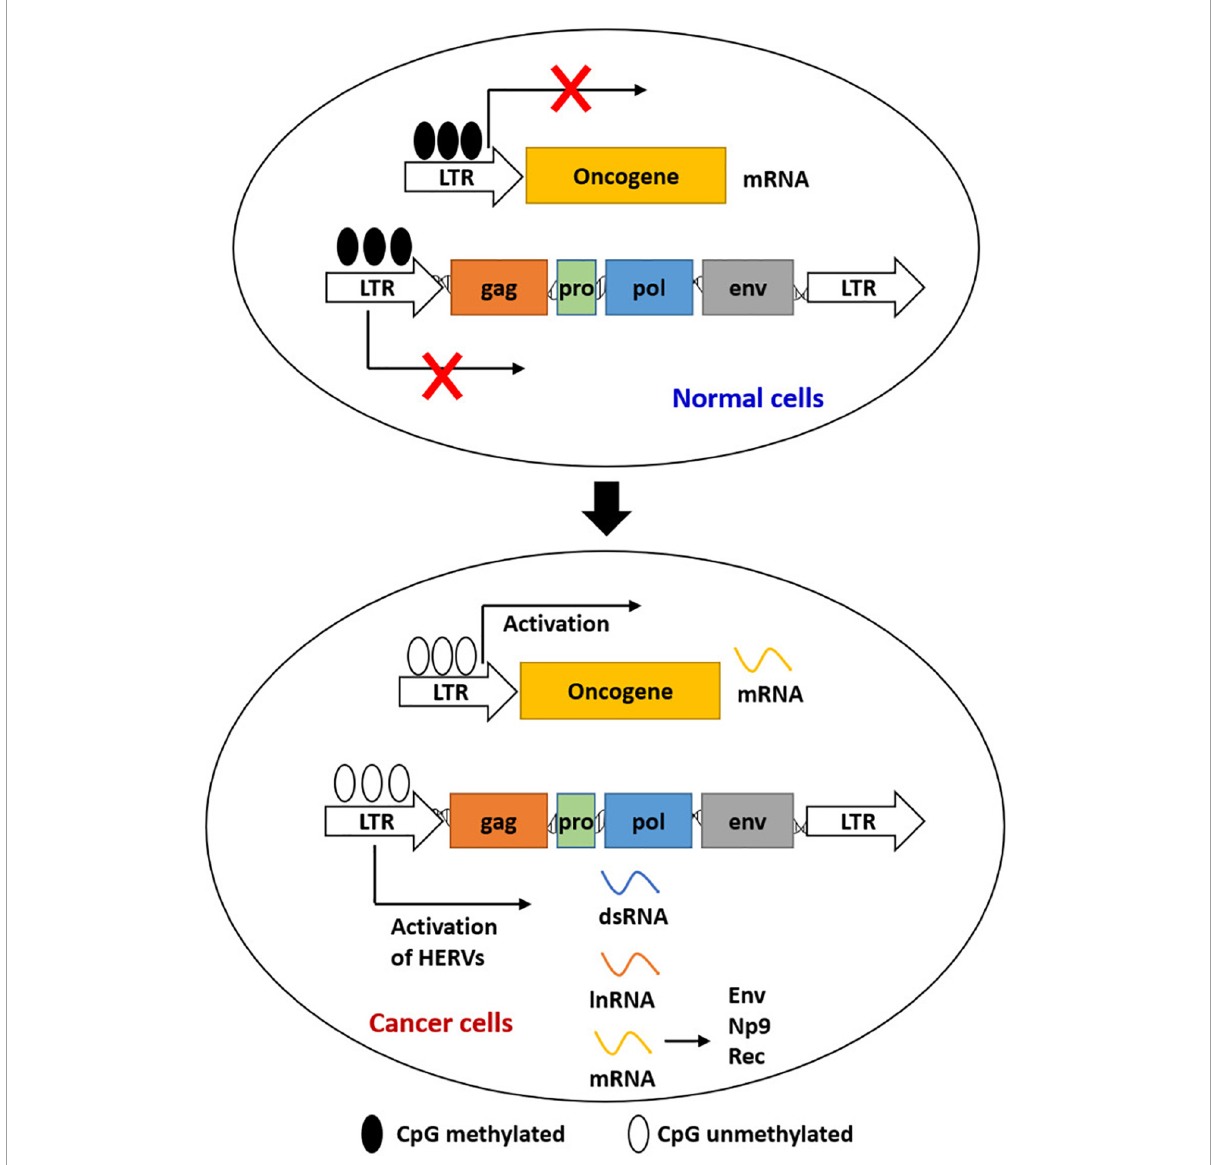
FIGURE1 Epigenetic regulation of the expression of HERVs and LTR-driven genes during carcinogenesis. Most HERVs/LTRs are inactivated in normal cells by DNA methylation. Activation of HERVs is induced by the global loss of DNA methylation in cancer cells. Activated HERVs can be transcribed into mRNAs, lncRNAs, and dsRNAs. LTRs can also act as the promoters of host genes to induce gene